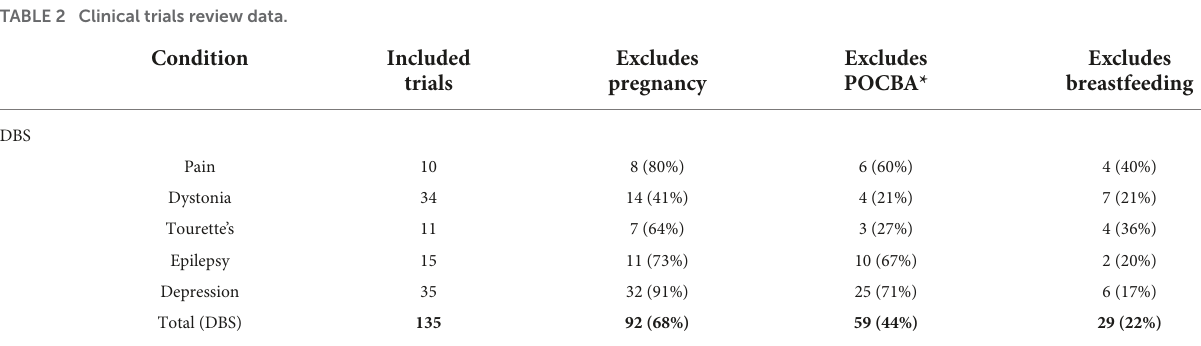
TABLE 2 Clinical trials review